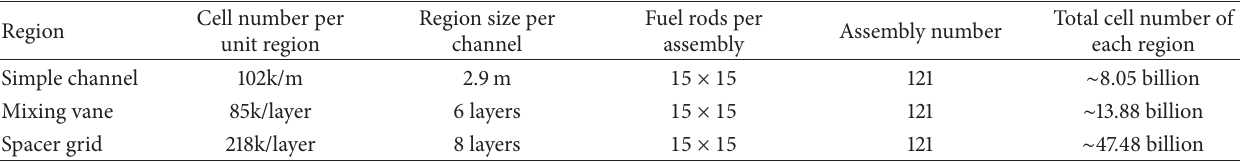
Table 5: Estimation of the cell number for the CFD simulation of Qinshan I.